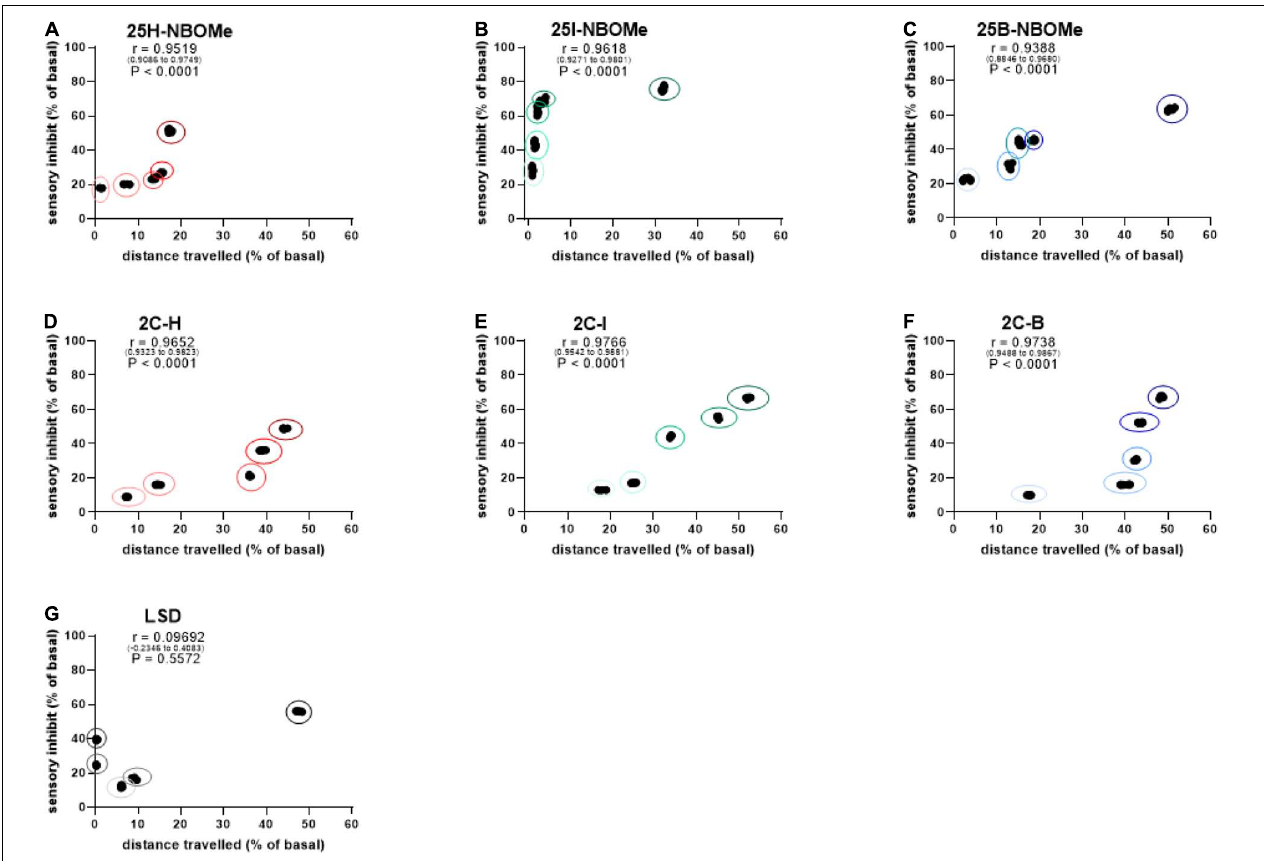
FIGURE 9 | Correlation between sensory dysperception and total distance traveled by mice following administration of 25H-NBOMe (0.001–10 mg/kg i.p.) (A) , 25I-NBOMe (0.001–10 mg/kg i.p.) (B) , 25B-NBOMe (0.001–10 mg/kg i.p.) (C) , 2C-H. (0001–10 mg/kg i.p.) (D) , 2C-I (0.001–10 mg/kg i.p.) (E) , 2C-B (0.001–10 mg/kg i.p.) (F) , and LSD (0.001–10 mg/kg i.p.) (G) observed after 1 h. Data are expressed as mean ± SEM ( n = 8/group). Statistical analysis was performed by XY correlation, which revealed a correlation between the two different effects of treatment for p < 0.0001 (2C-H, 2C-I, 2C-B, 25H-NBOMe, 25I-NBOMe and 25B-NBOMe) and p = 0.5572